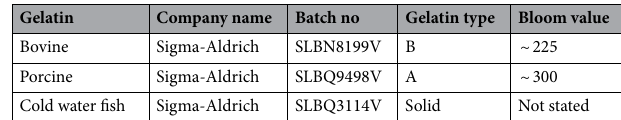
Table 1. General descriptions of gelatin samples used in this